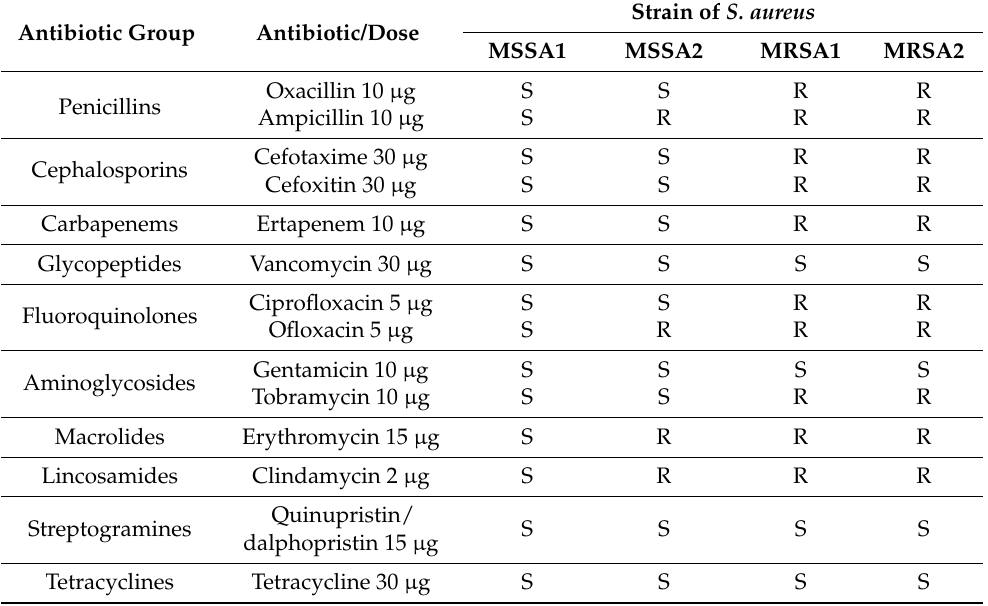
Table 1. Antimicrobial susceptibility profiles of S. aureus isolates. Antibiotic Group